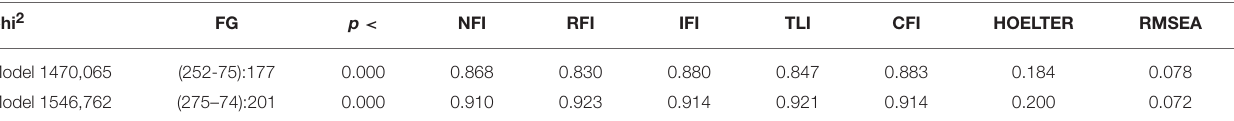
Table 7 | Models of structural lineal results of the